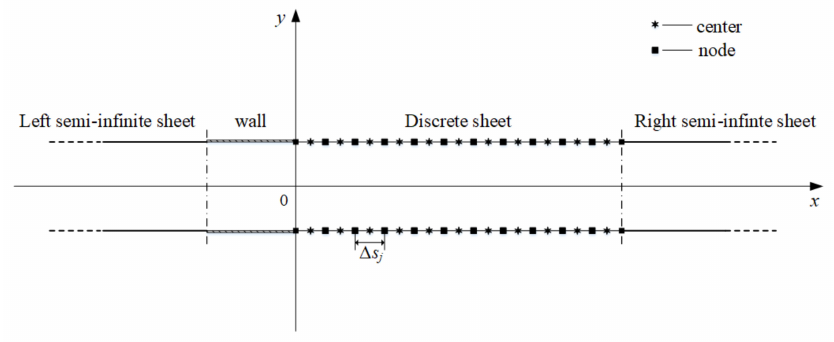
Figure 3. Discrete jet